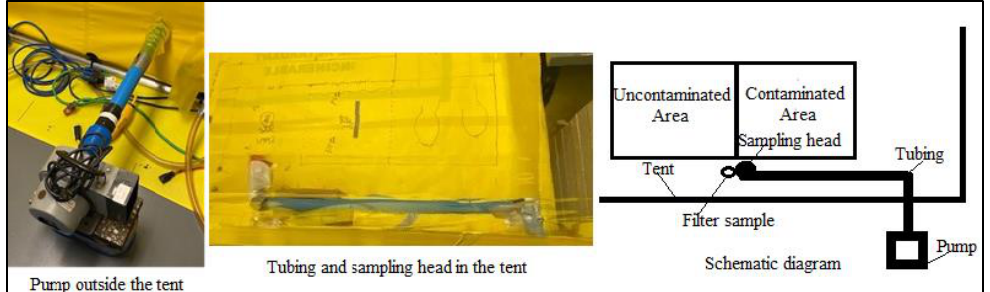
Figure 5. Schematic Diagram of High-Volume Sampler and Filter Sample Setup ( left ); with pictures of the pump ( right ) and tubing and sampling head ( middle ) to show a relationship to the containment tent.